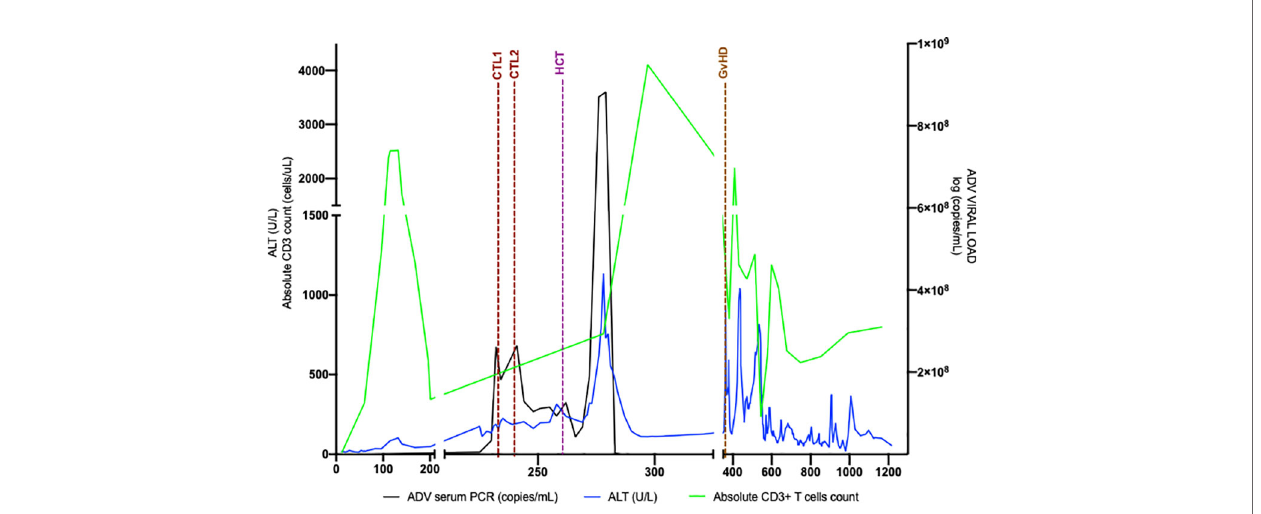
FIGURE 2 | Adenoviremia cleared with Unmanipulated MSD HCT. Adenovirus viral load followed over time as compared with ALT and absolute CD3+T cell quantity. ALT is an indicator of liver in fl ammation and CD3+T cell quantity changes after MSD. Post MSD HCT, adenoviral load rapidly increases, as does ALT, likely secondary to rapid viral lysis from donor-derived CD3+ T cells. ADV, adenovirus; ALT, alanine aminotransferase; CTL, cytotoxic T lymphocyte infusion; GvHD, graft versus host disease HCT, hematopoietic cell transplant; MSD, matched sibling